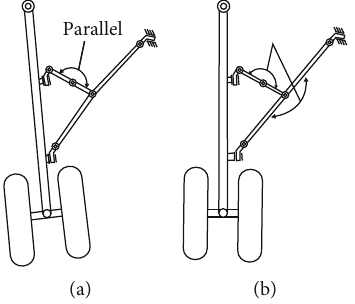
Figure 10: Landing gear mechanism corresponding to the vicinity of point